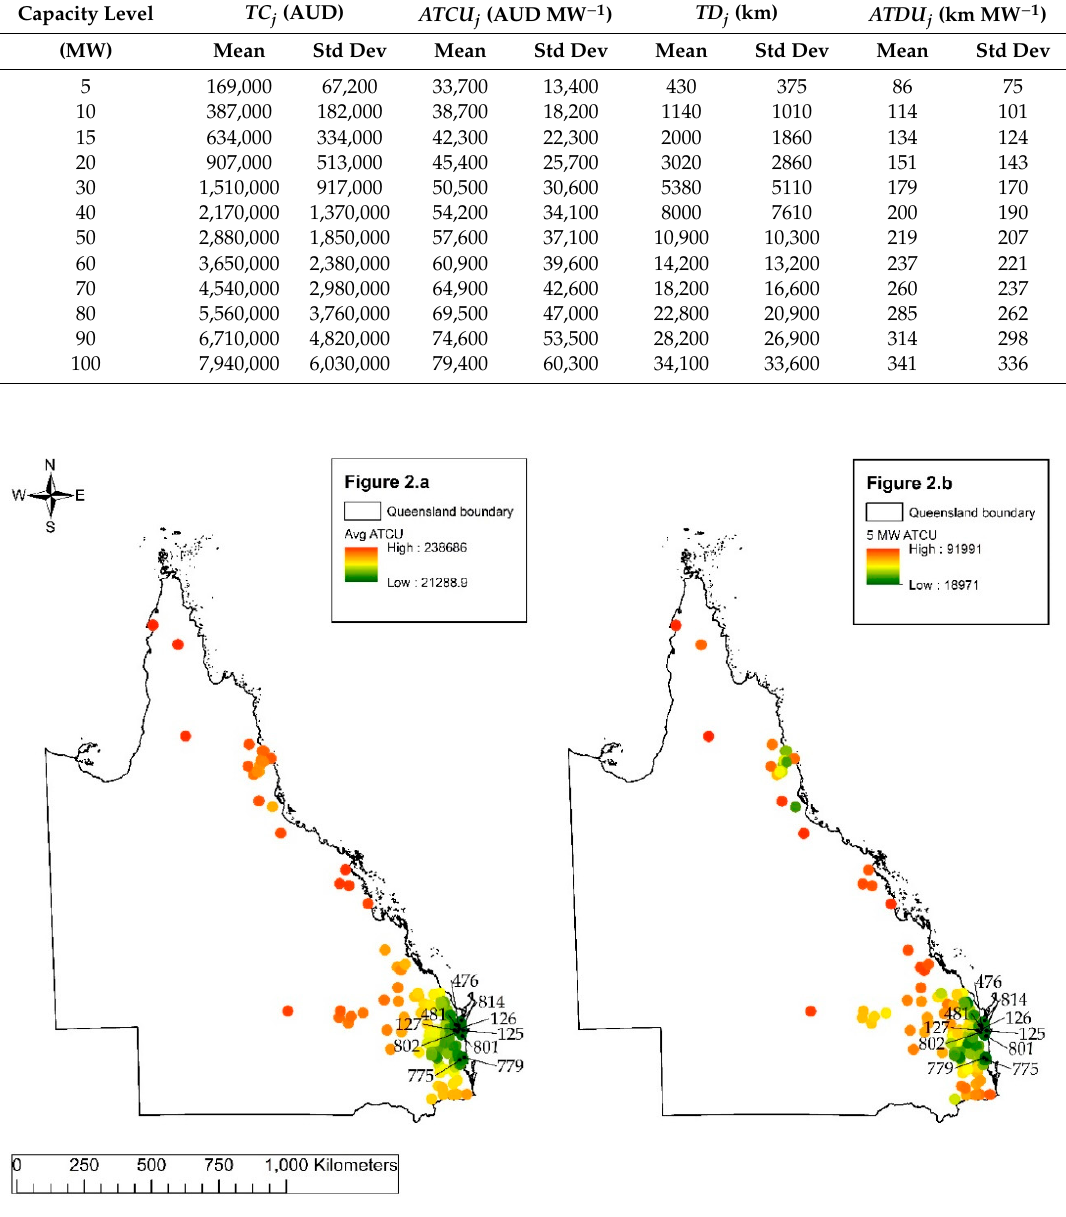
Figure 2. ( a ) Strategic facility locations indexed by the average ATCU j calculated over a 5–100 MW capacity range. ( b ) Strategic facility locations indexed by the ATCU j at 5 MW. The 10 best locations with the lowest ATCU j across all capacities are labelled.